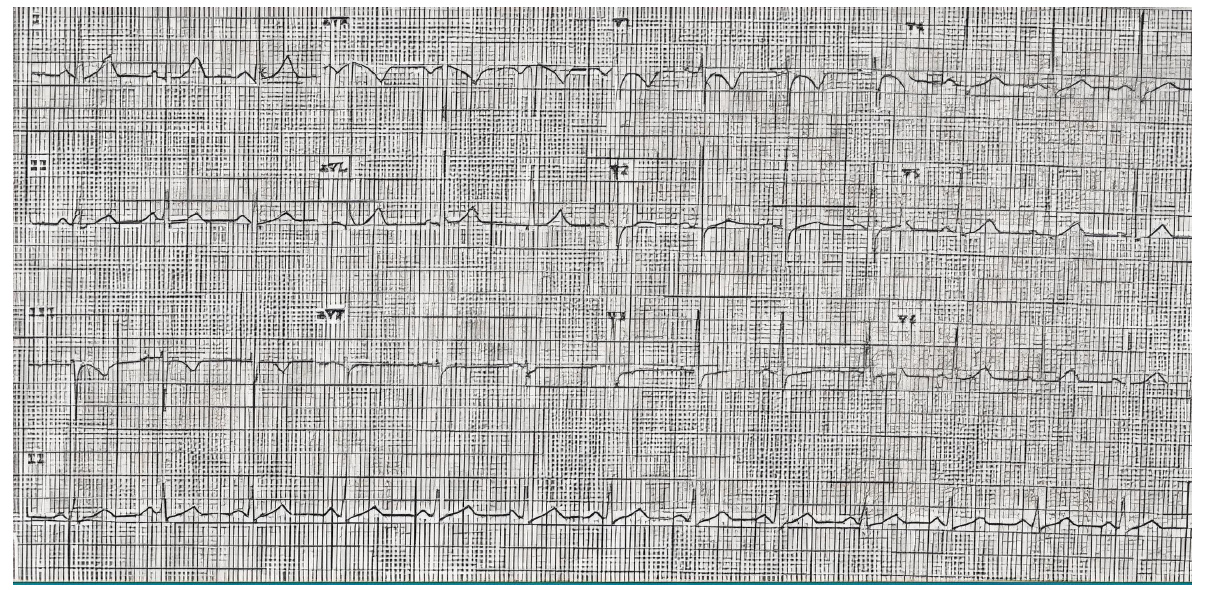
Figure 3. Ambulatory electrocardiogram of index patient IV.17.: Sinus rhythm, narrow QRS and negative T waves in V1 and flattened in V2–V3.